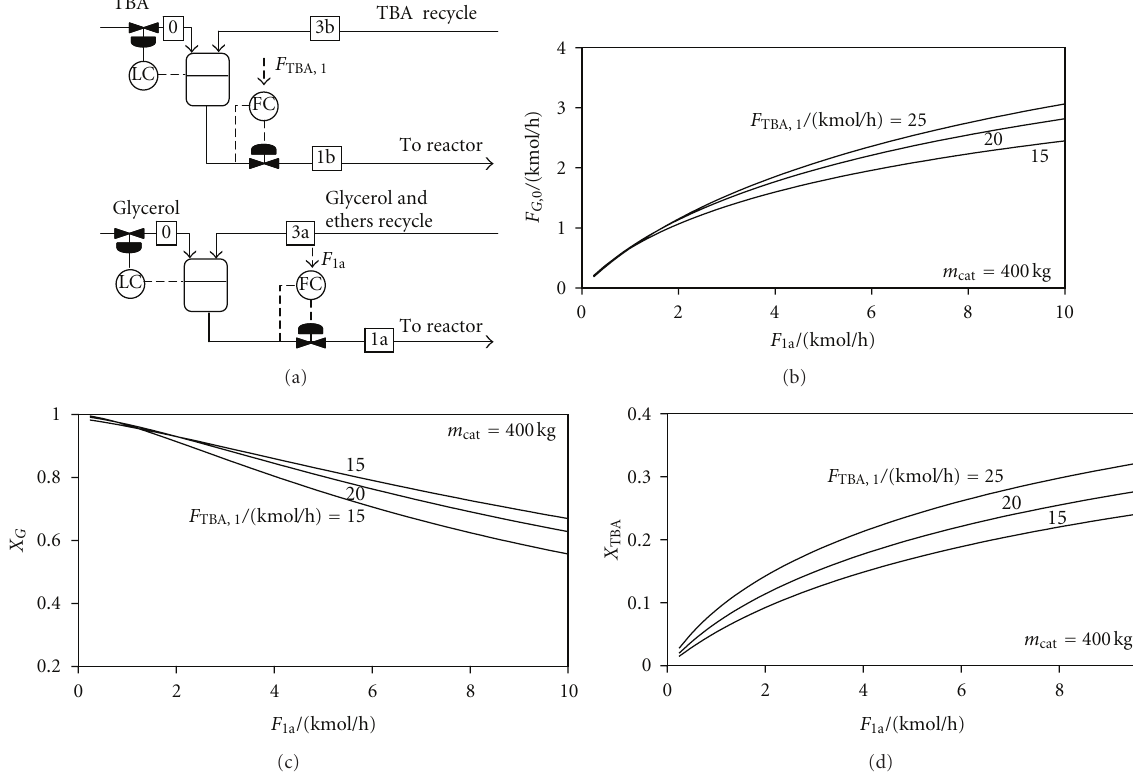
Figure 2: Control structure CS1. Processed glycerol and reactants conversion versus reactor-inlet glycerol + ethers flow